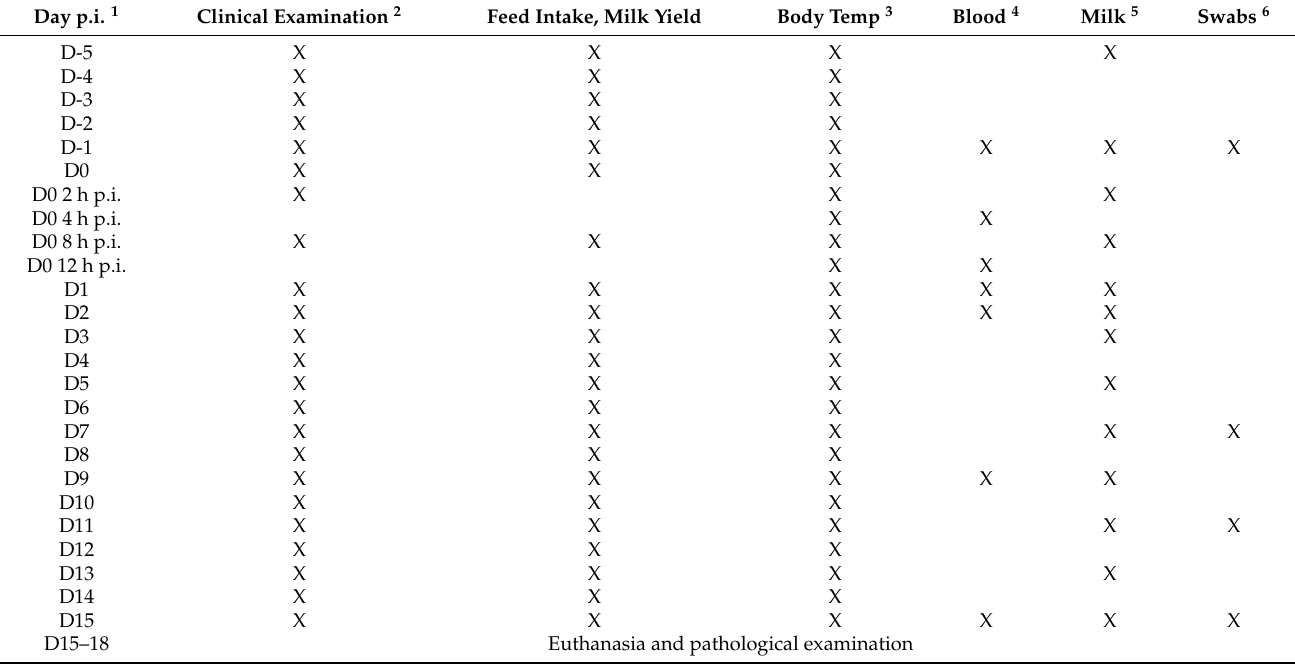
Table 2. Monitoring the clinical course of infection and sample collection.